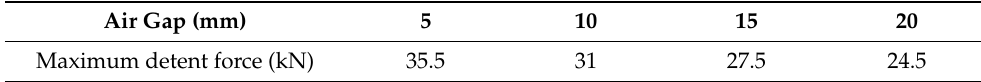
Table 1. The maximum detent force under different air gaps.